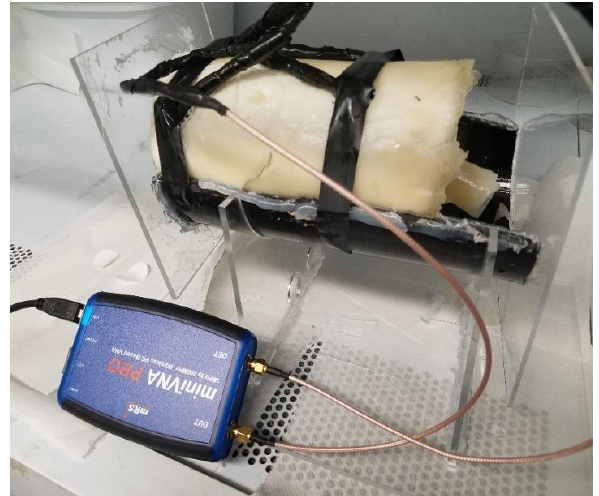
Figure 2. The constructed five-tissue layers arm phantom model in a measurement’s setup scenario (connected to the miniVNA).